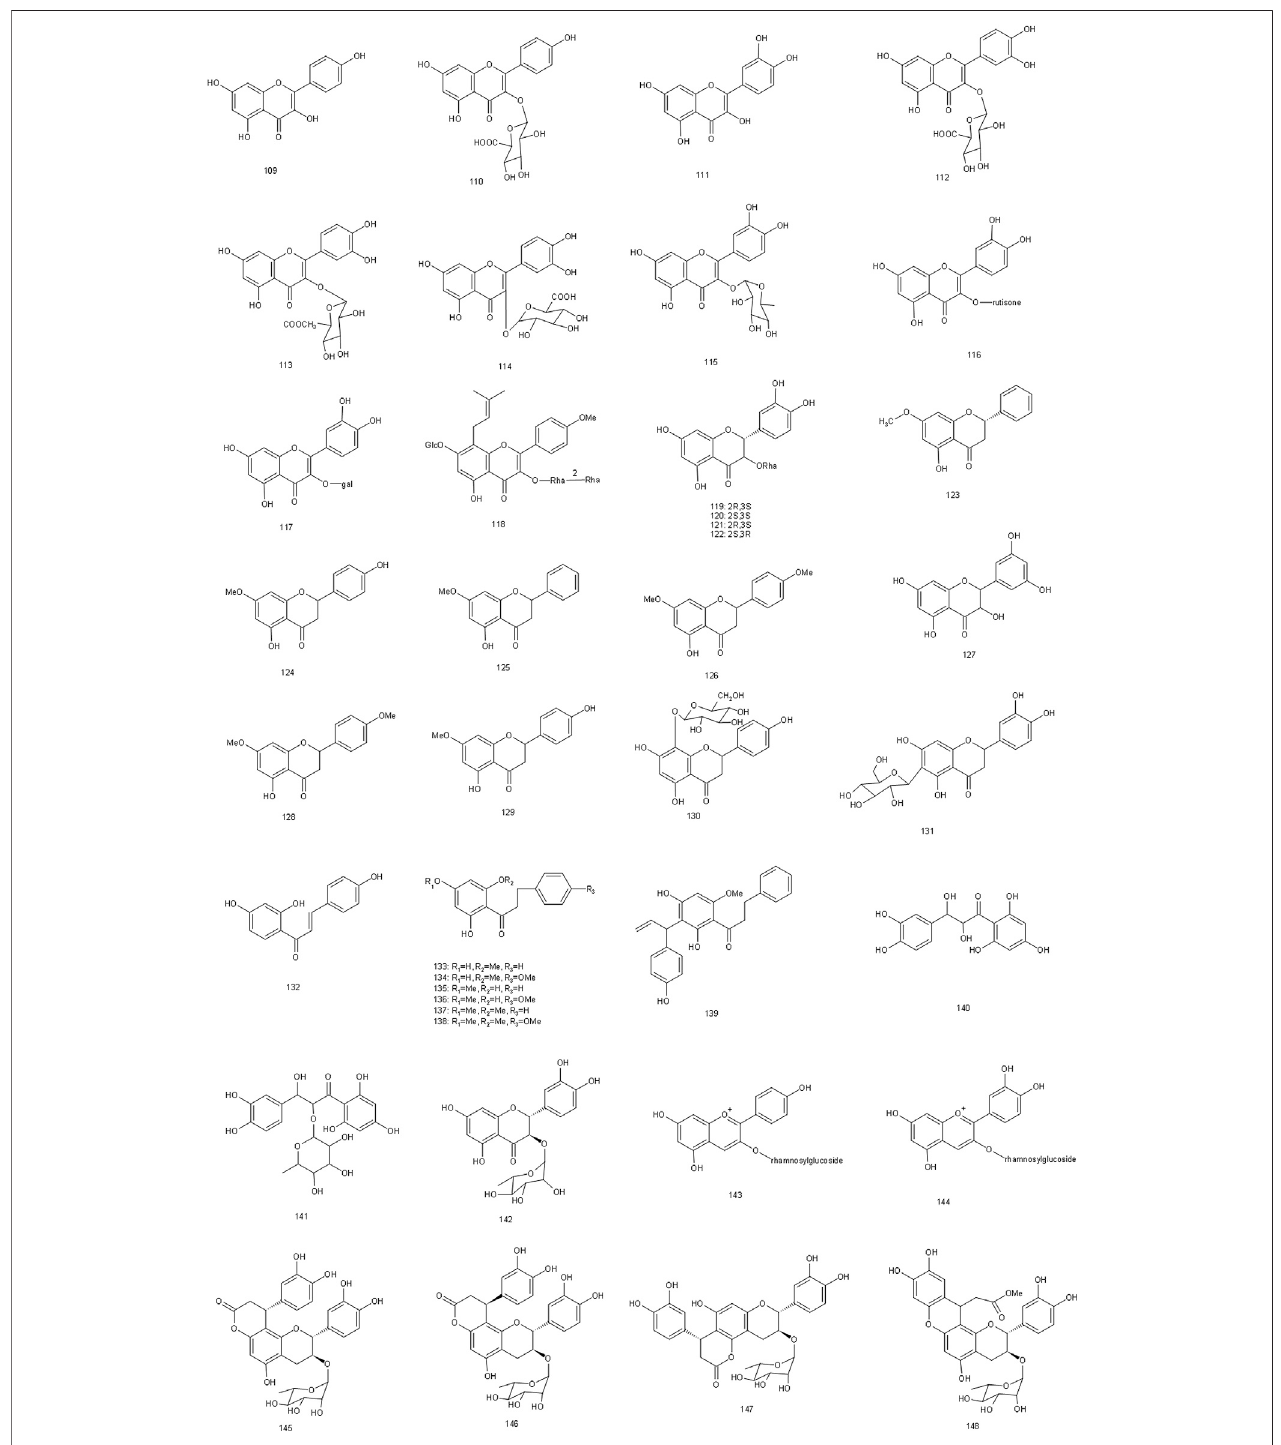
FIGURE 4 | Chemical structures of fl avonoids identi fi ed in S. glabra extract.